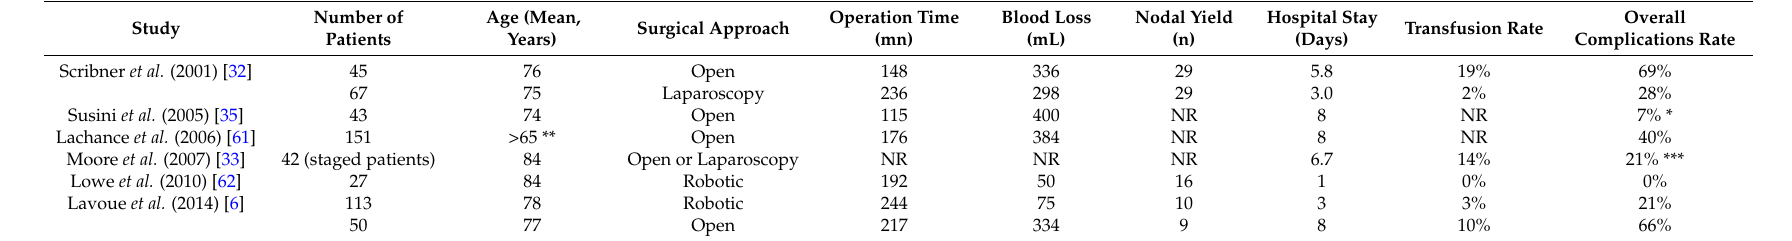
Table 1. Studies about surgical staging in elderly with endometrial